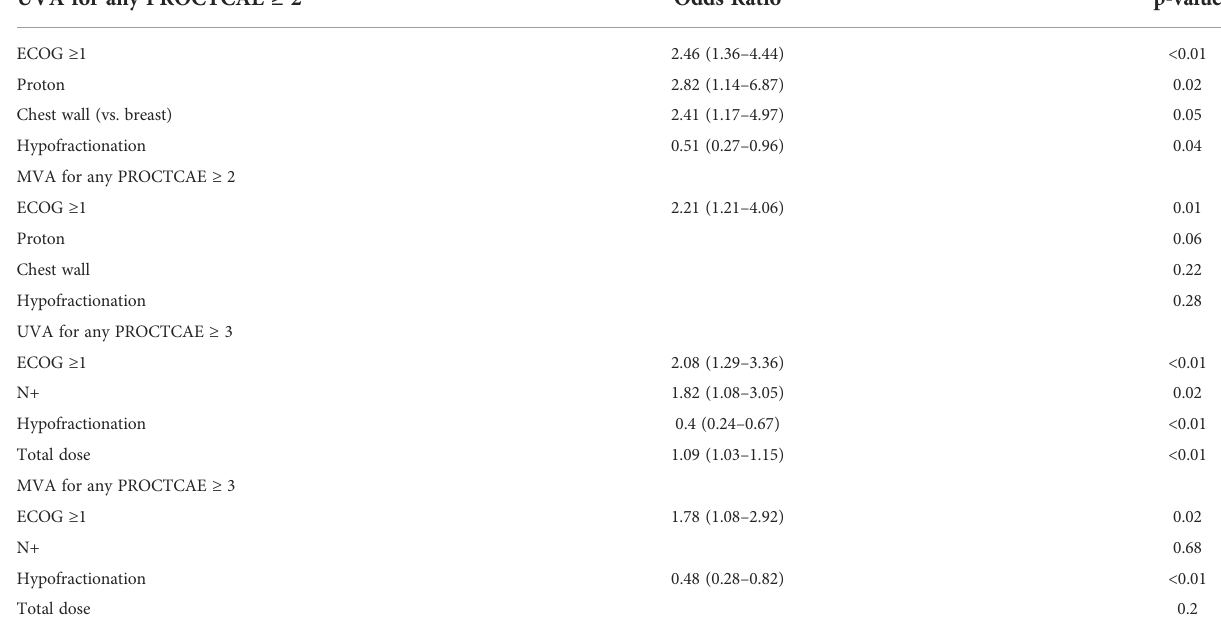
TABLE 5 Univariate and multivariate analysis for any PRO-CTCAE ≥ 2 and ≥